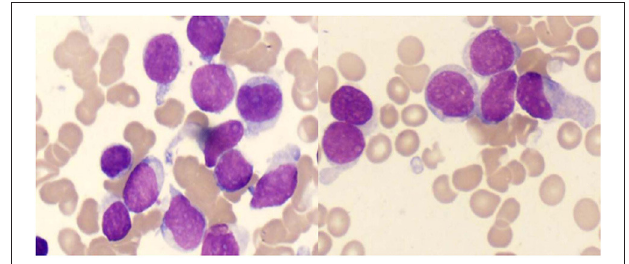
FIGURE 2 | Image of the bone marrow in acute lymphoblastic